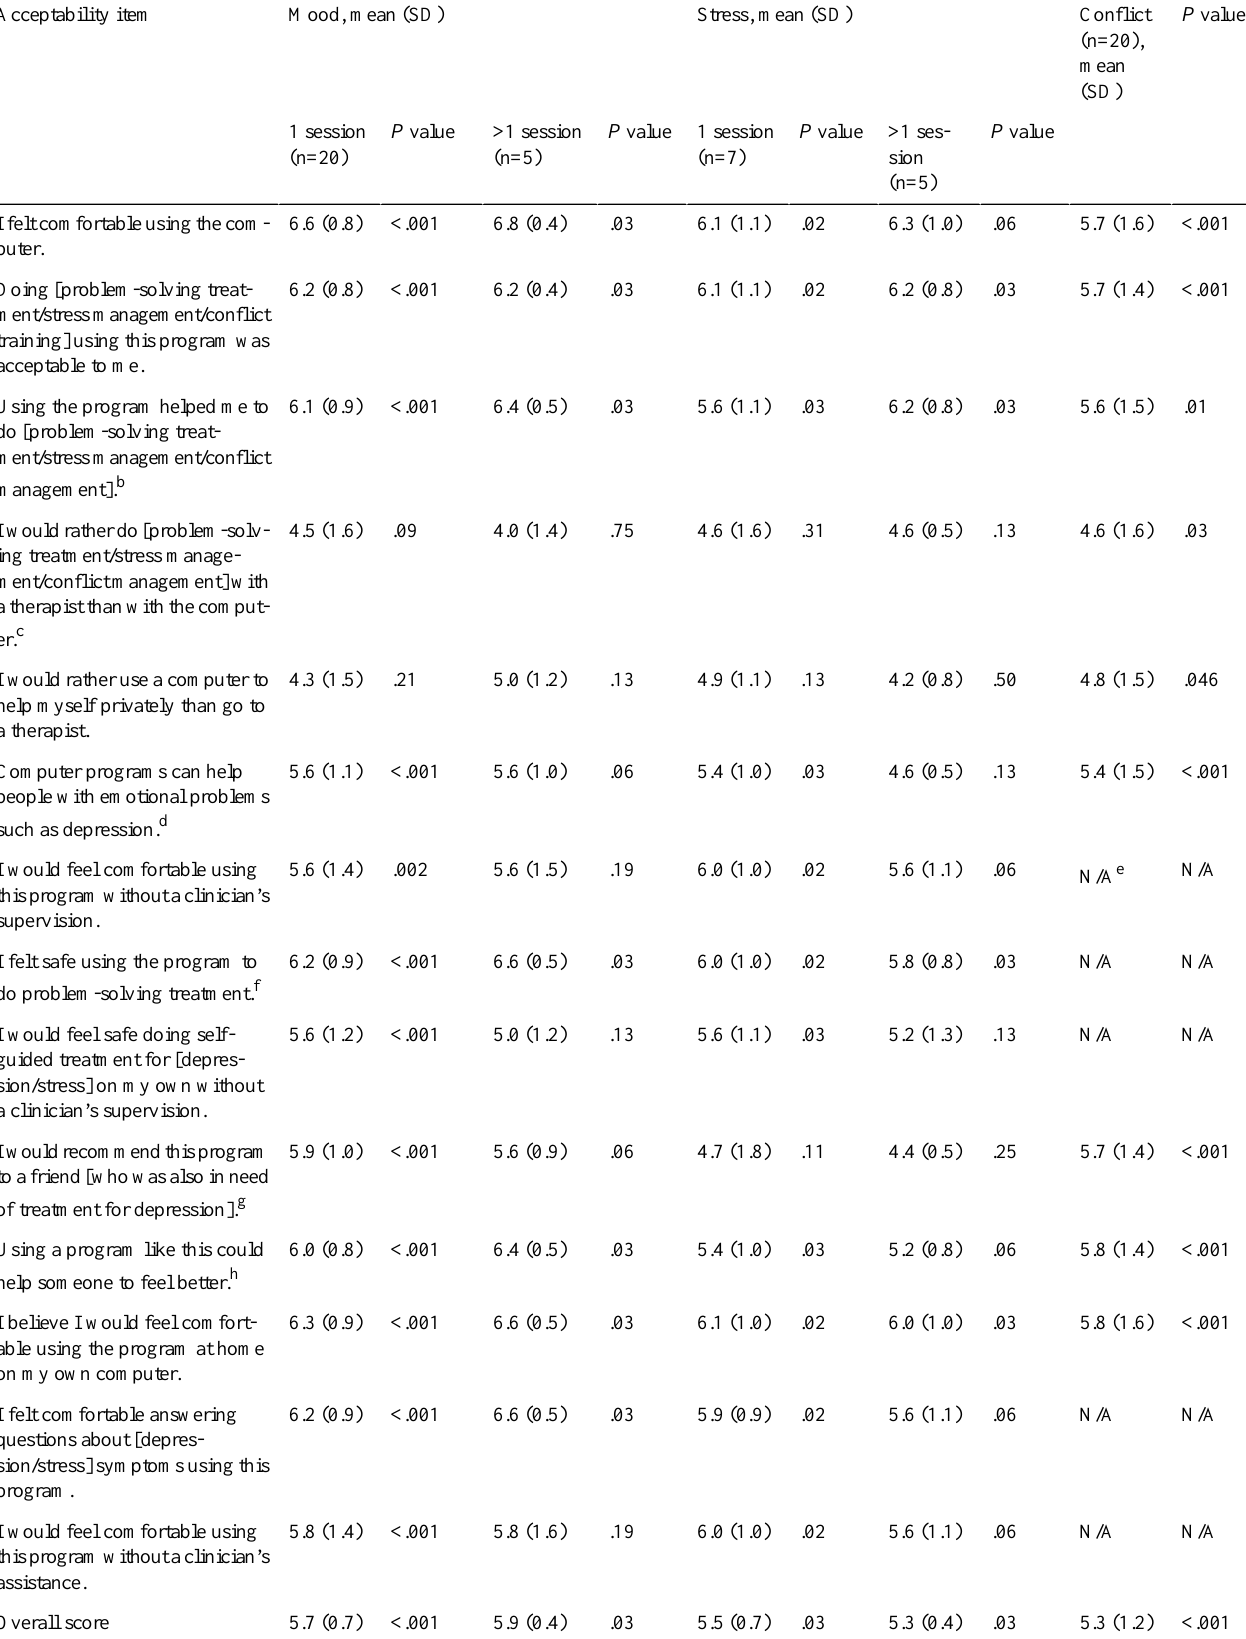
Table 4. Acceptability of Self-Guided Treatment Questionnaire scores for the mood, stress, and conflict modules. a